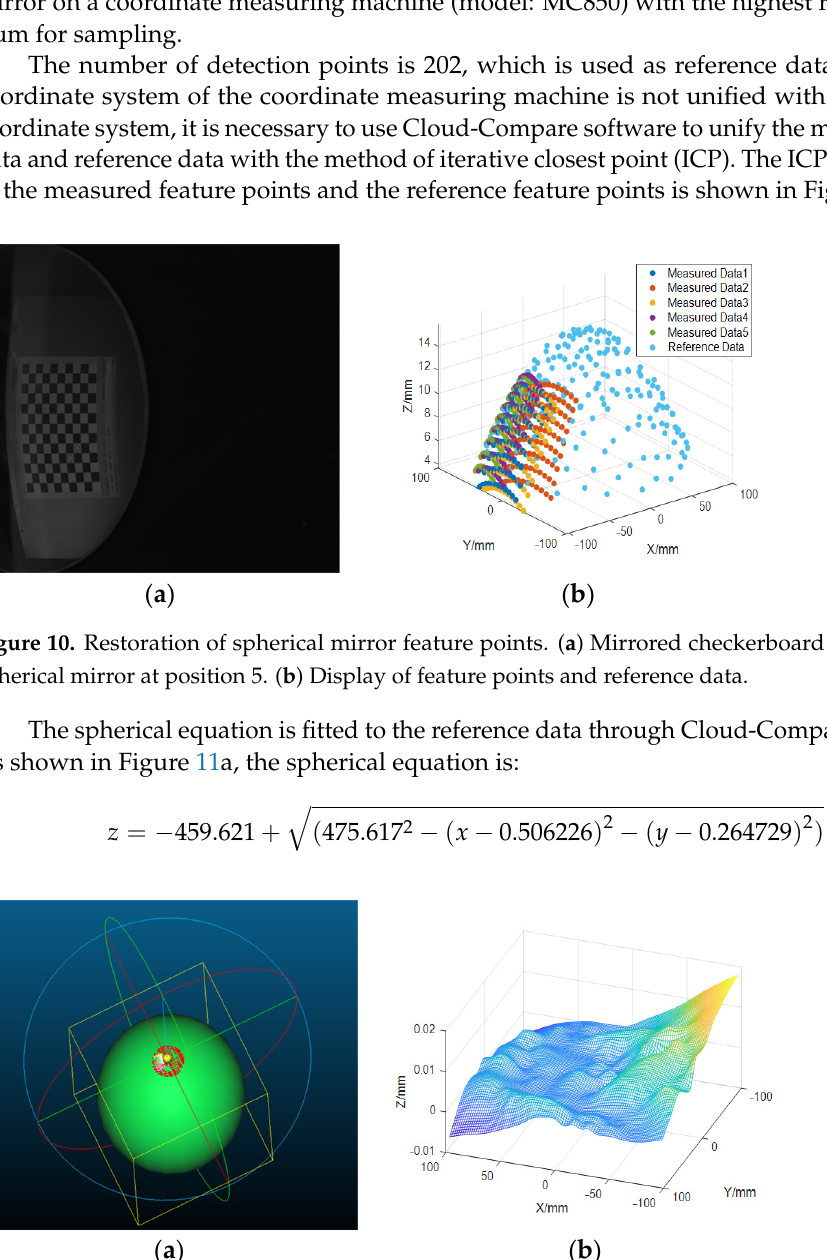
Figure 11. Spherical equation fi tt ing of reference points. ( a ) Spherical equation fi tt ing. The fi tt ing result: radius of the spherical mirror is 475.62 mm. RMSE = 0.01 mm, the manufacturing error can be ignored. ( b ) Surface fi tt ing error.